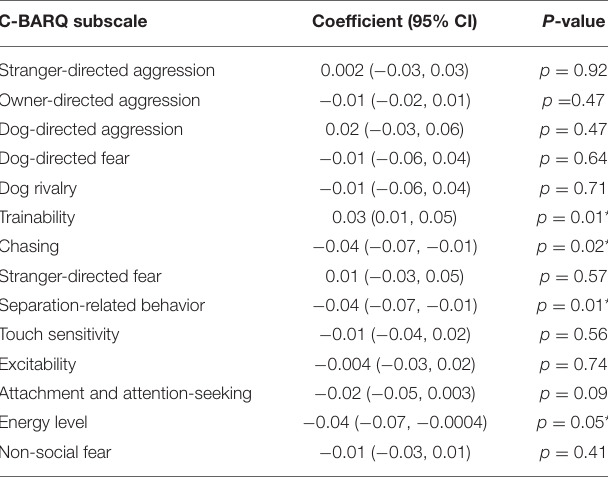
TABLE 3 | Mixed effects models examining the change in C-BARQ subscale scores following clinical behavioral intervention. C-BARQ